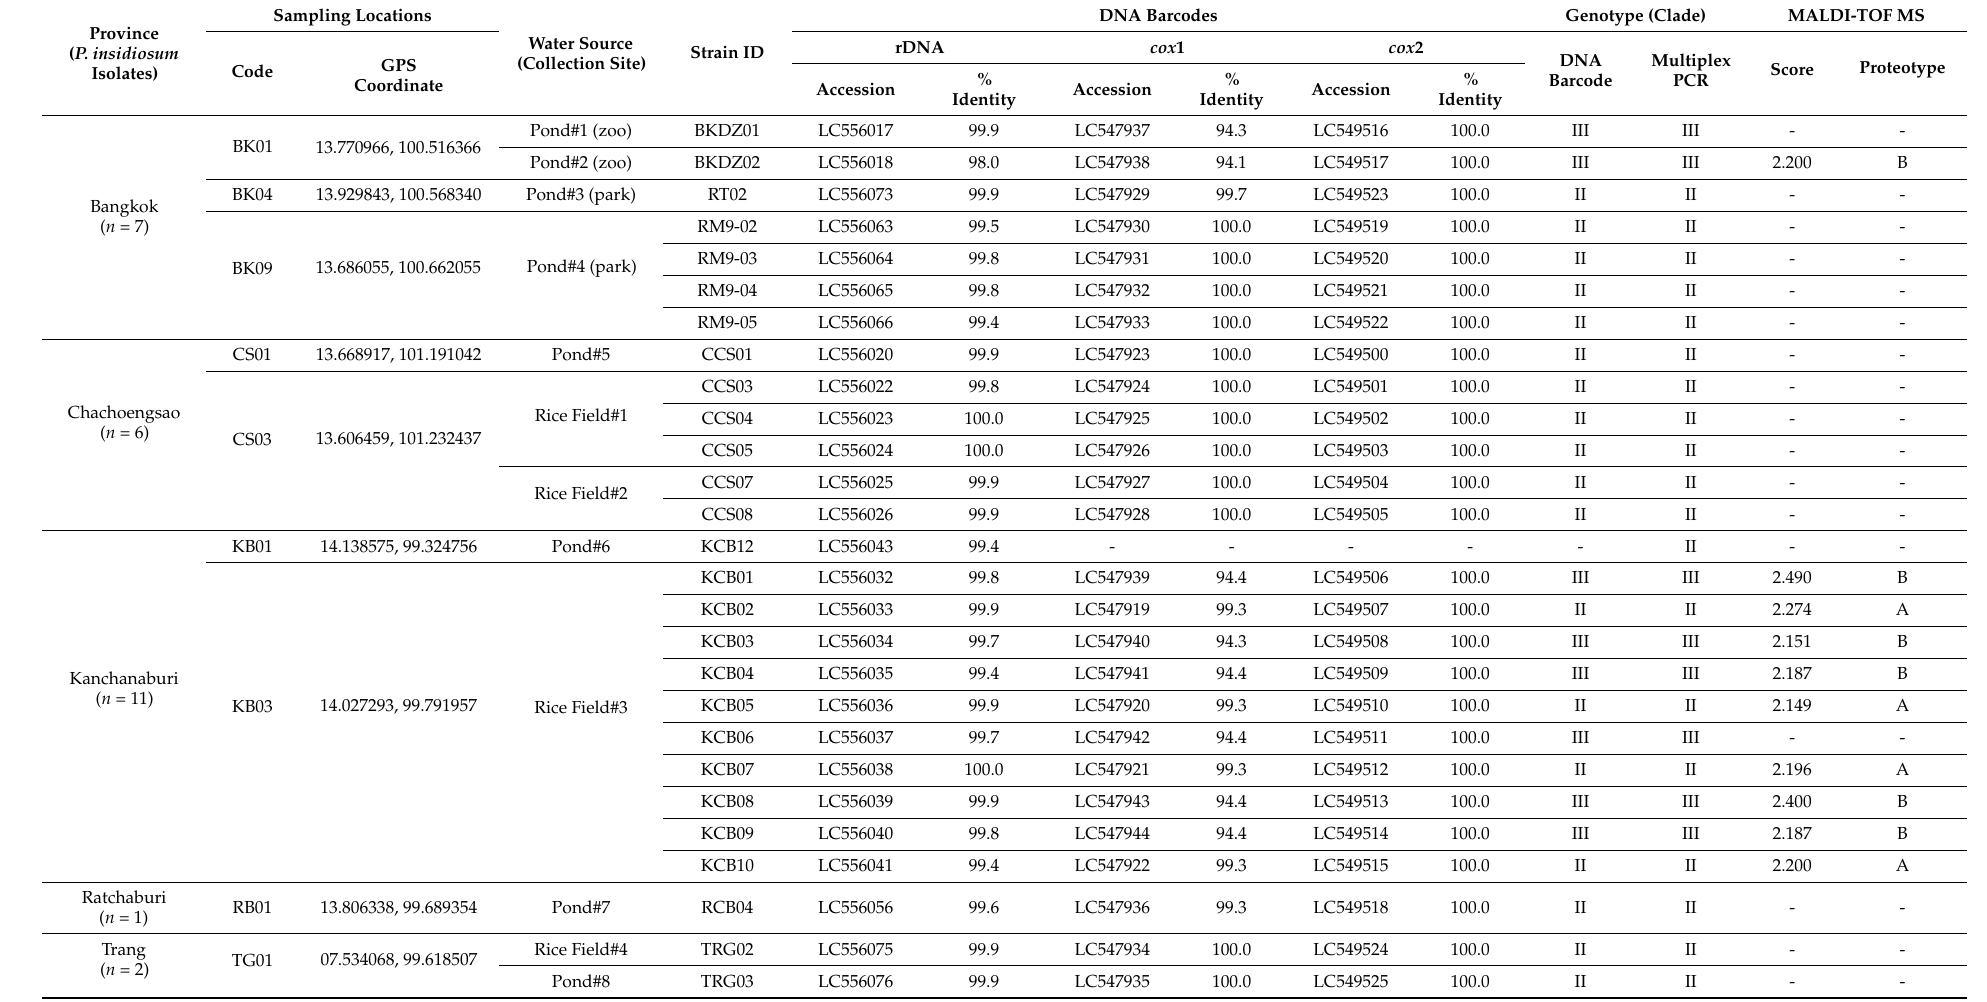
Table 2. Twenty-seven strains of P. insidiosum successfully isolated from 5 provinces in Thailand. Sampling locations (with GPS coordinates), water sources, strain IDs, sequence homology analyses, and species-level identification and biotyping (based on DNA barcodes, multiplex PCR, and mass spectrometry) are summarized in the Table. Province ( P. insidiosum